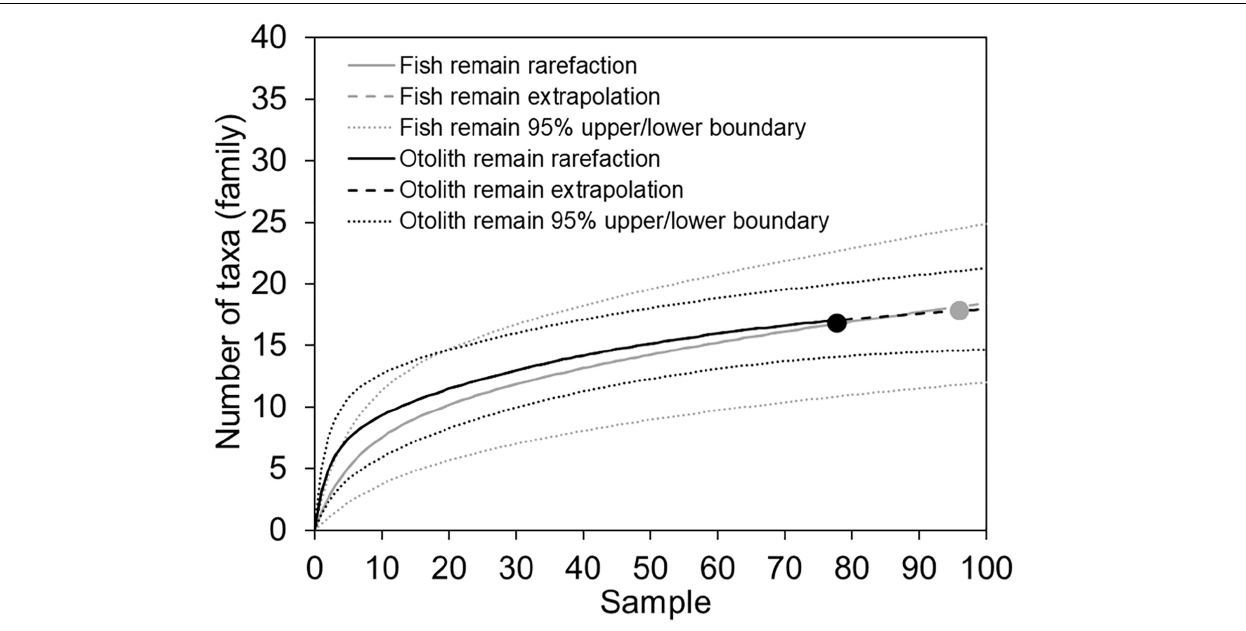
FIGURE 3 | Sample-based rarefaction and extrapolation curves with 95% confidence intervals. Prey taxa are counted at family level. There were 94 and 77 reference samples for fish and otolith remains,